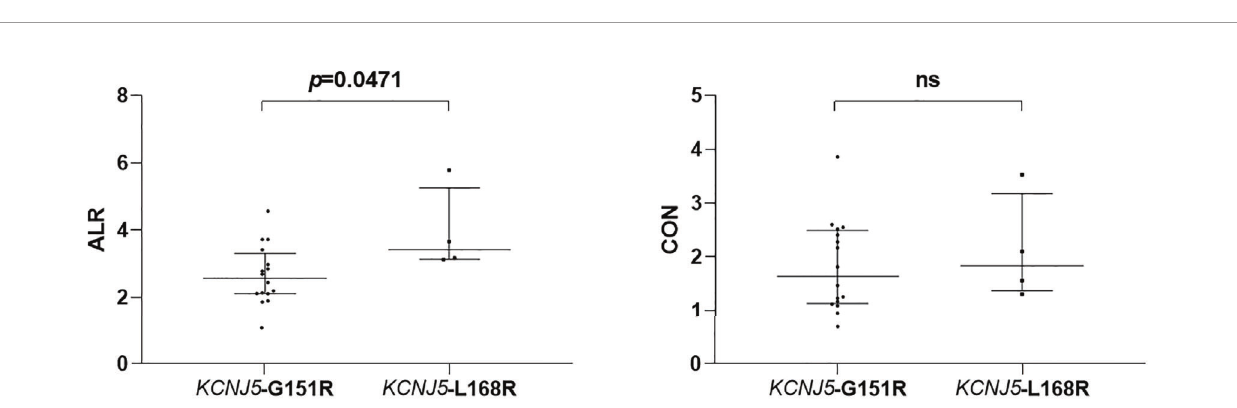
FIGURE 2 | Comparison of semiquantitative parameters of NP-59 adrenal scintigraphy according to different point mutations of KCNJ5 . ns, non-signi fi